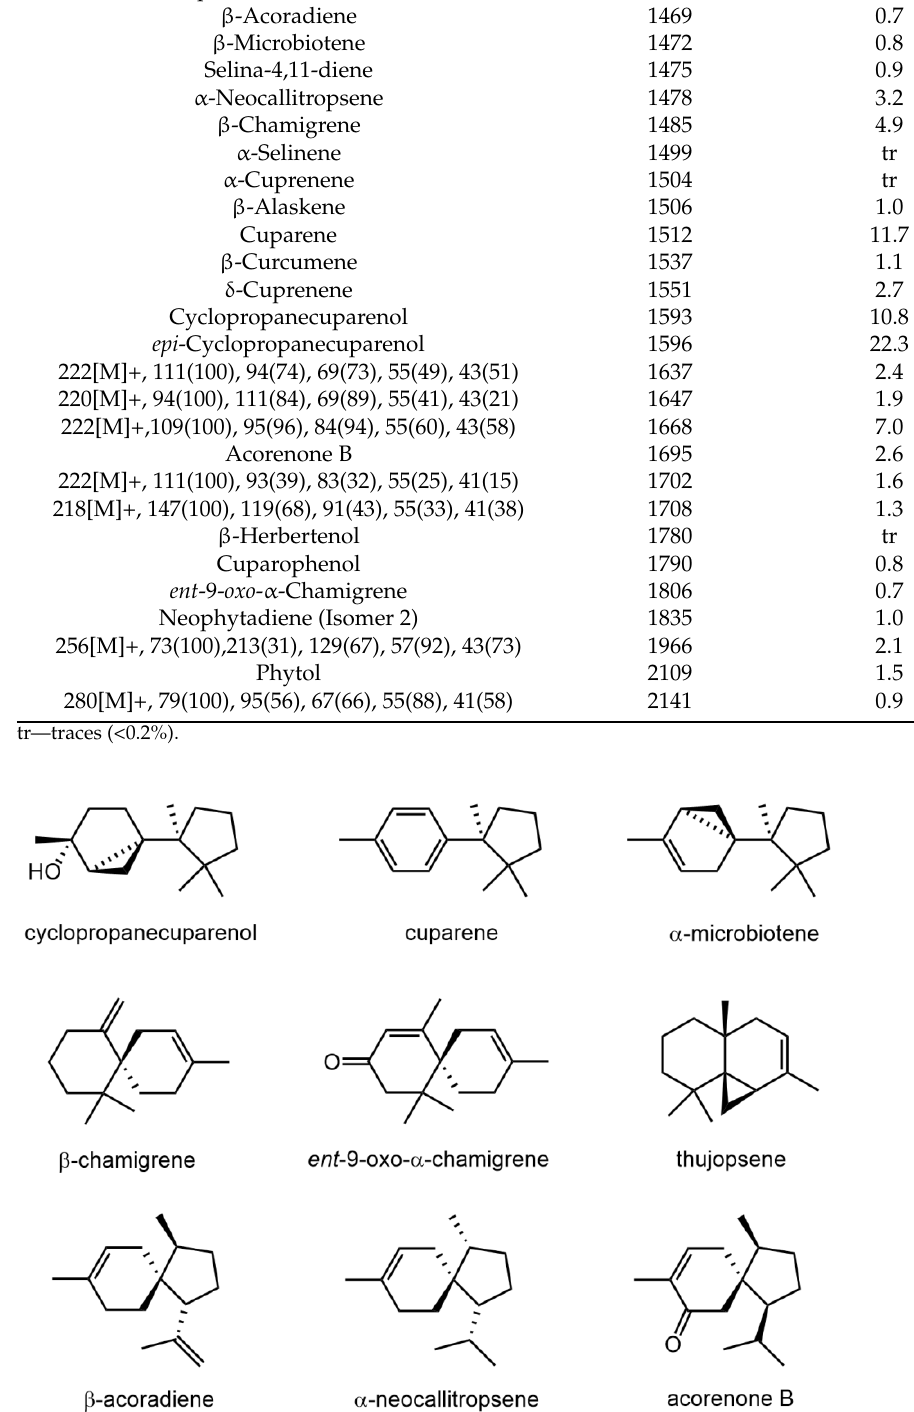
Figure 1. Structures of the most characteristic volatile components found in thalli of Marchantia polymorpha .